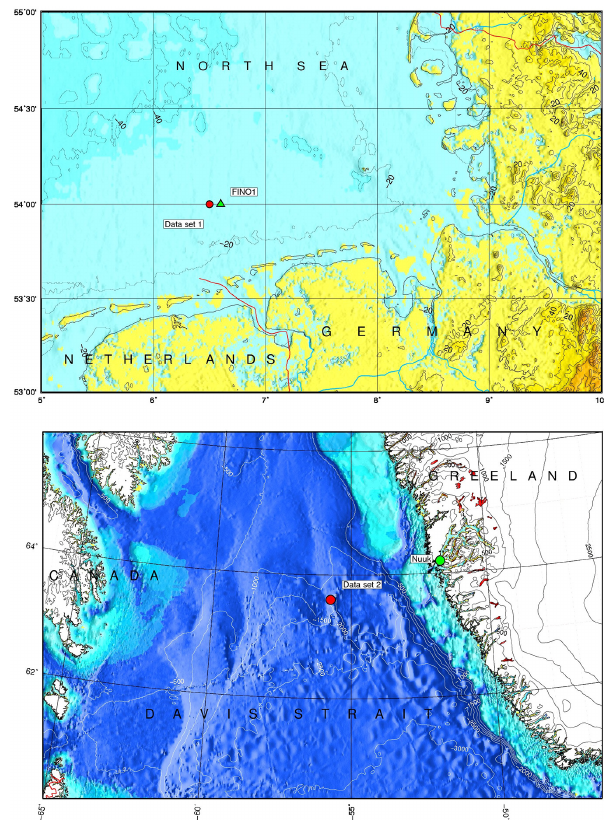
Figure 2. Locations of the two example data sets (red). In the upper panel, the data’s location near the island of Borkum in the German North Sea is depicted. Additionally the observation station FINO1 is marked (green). In the lower panel, the data’s location west of the coast of Greenland, near Nuuk, is